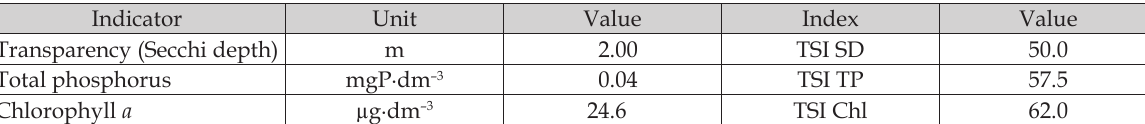
Table 3. Trophic state index TSI (following carlson 1977) of lake Umultowskie (klimaszyk 2006). Indicator